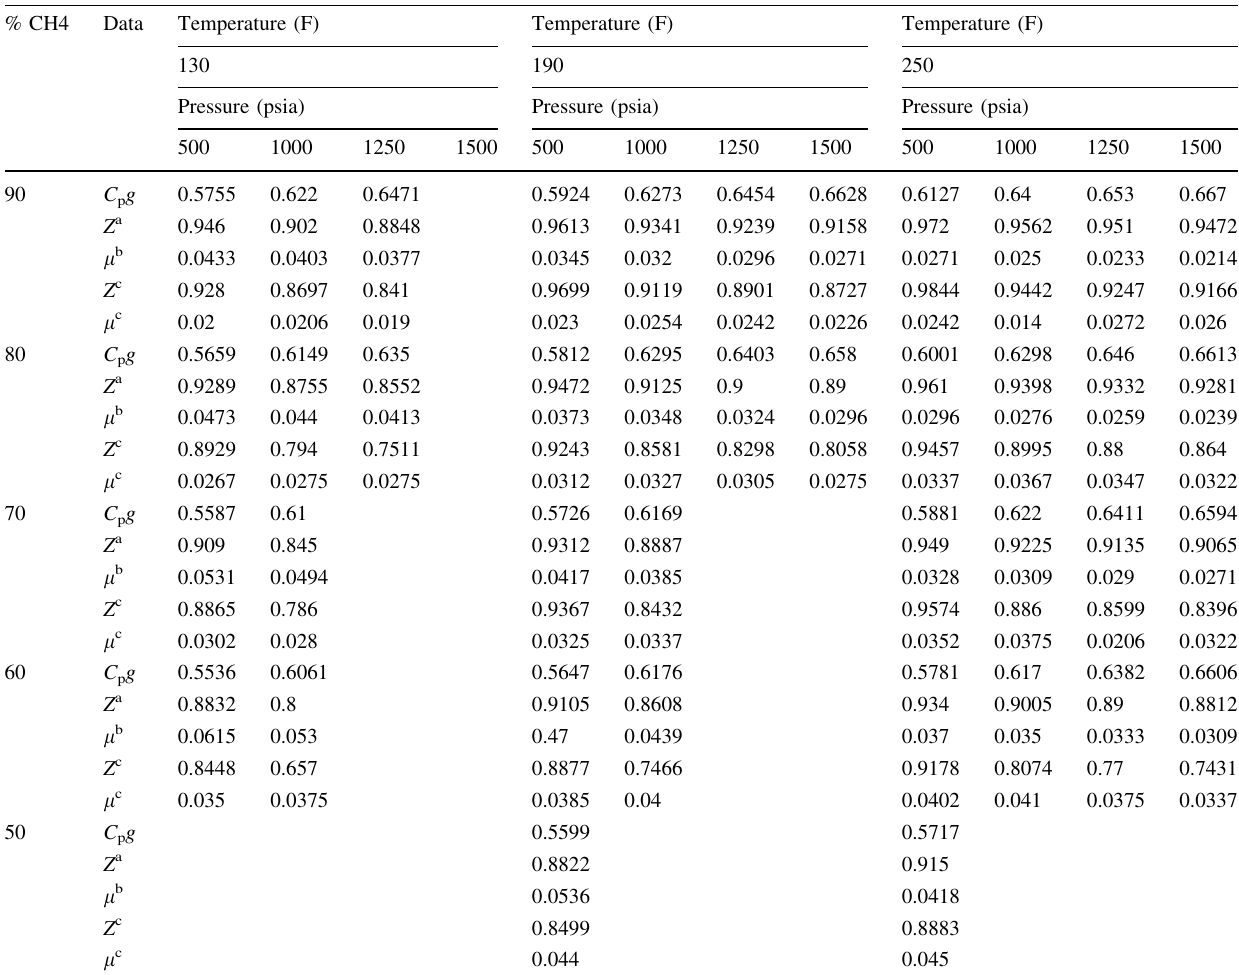
Table 6 Evaluation of Z factors and JT coefficients for different methane–n-butane systems in the gaseous and liquid regions %